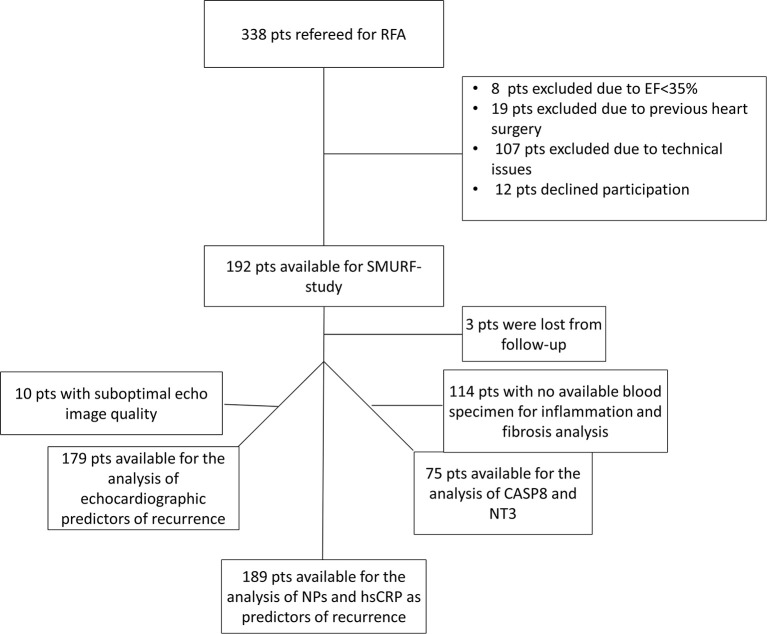
Flow chart of the study participation inclusion. AF, atrial fibrillation; CASP8, caspase 8EF: ejection fraction; pats, patients; hsCRP, high sensitive C-reactive protein; RFA, radiofrequency ablation; NP, natriuretic peptides; NT3, neurotrophin-3.